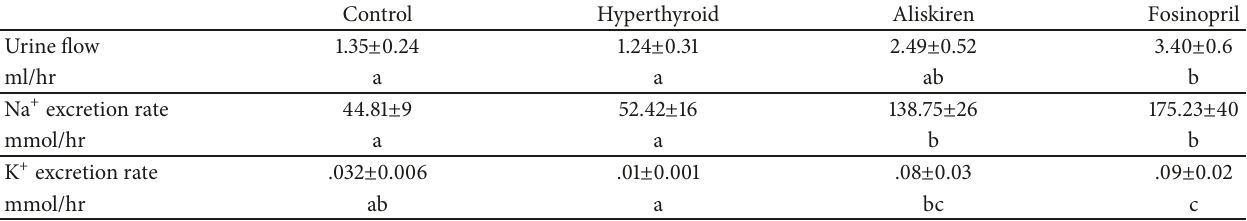
Table 8: Urine flow, Na + excretion rate, and K + excretion rate in hyperthyroidism, Aliskiren, and